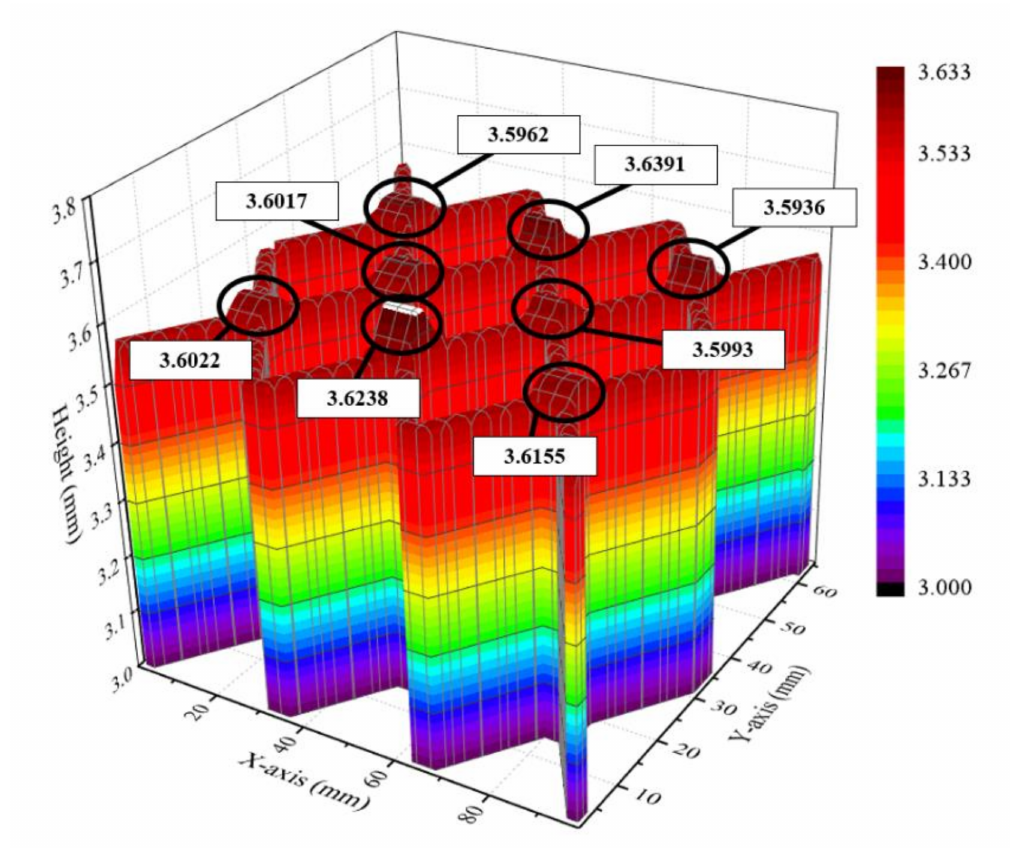
Figure 8. The height value of the single-layer experiment at each